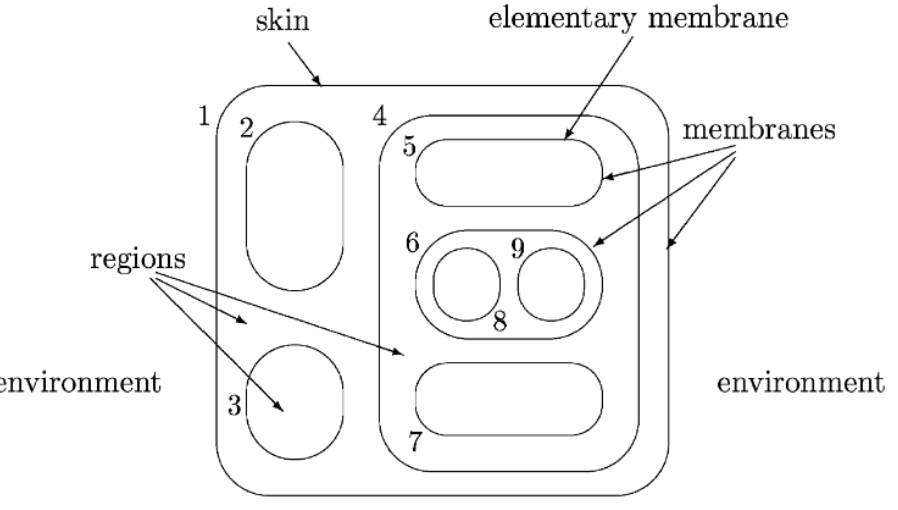
Figure 2. Example membrane structure